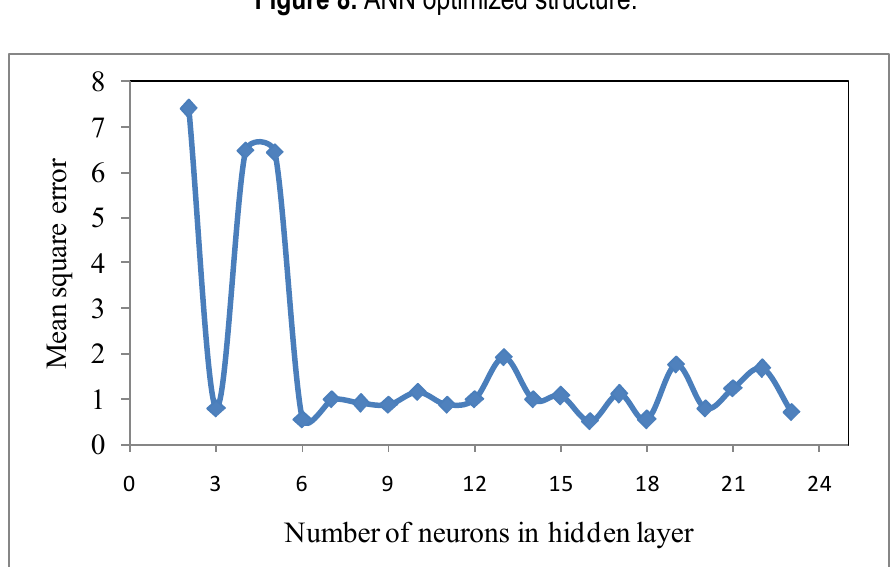
Figure 8. ANN optimized structure.